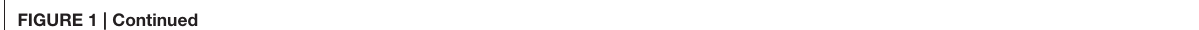
astrocytes cultured with CM in 1% alginate discs at 24 h ( Figure 5 ), with statistically higher storage modulus values than those of discs with astrocytes and of discs without